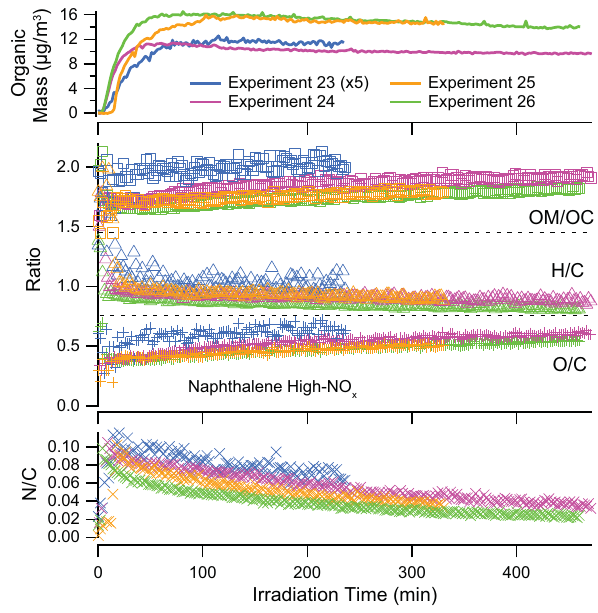
Fig. 11. Organic mass (not corrected for collection efficiency), ele- mental ratios,and OM/OCfornaphthalene high- NO x experiments. Experiment 23 is in blue, 24 in pink, 25 in orange and 26 in green. Dotted lines are provided to visually separate different ratios.